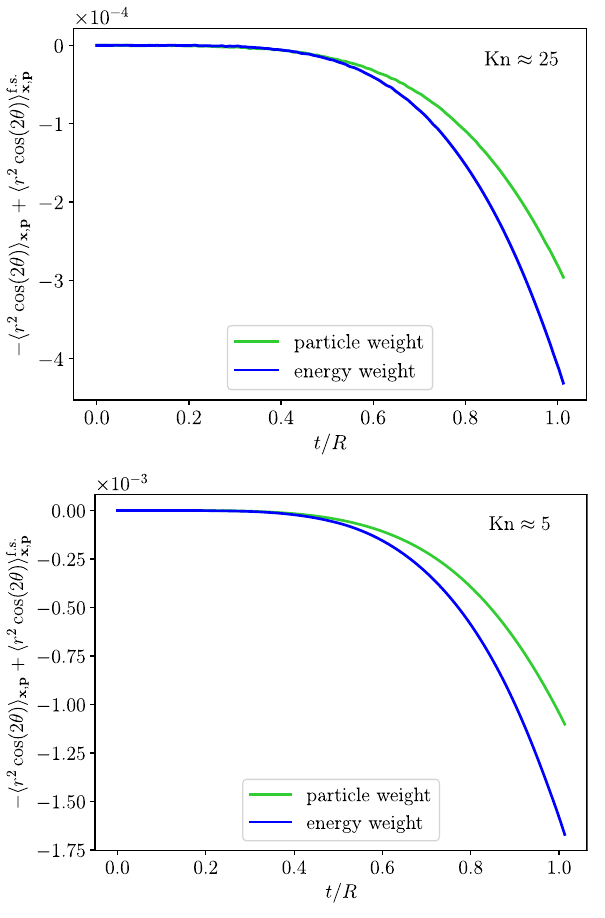
Fig. 9 Time evolution of the departure of −(cid:3) r 2 cos ( 2 θ) (cid:4) x , p with particle-number (green) and energy (blue) weighting from its free streaming value, for simulations with Kn ≈ 25 (top panel) or Kn ≈ 5 (bottom panel)